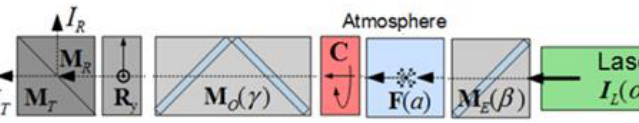
Figure 1: Müller-Stokes schematic of a two- channel, polarisation-sensitive lidar setup (adapted from[1].). Müller matrix